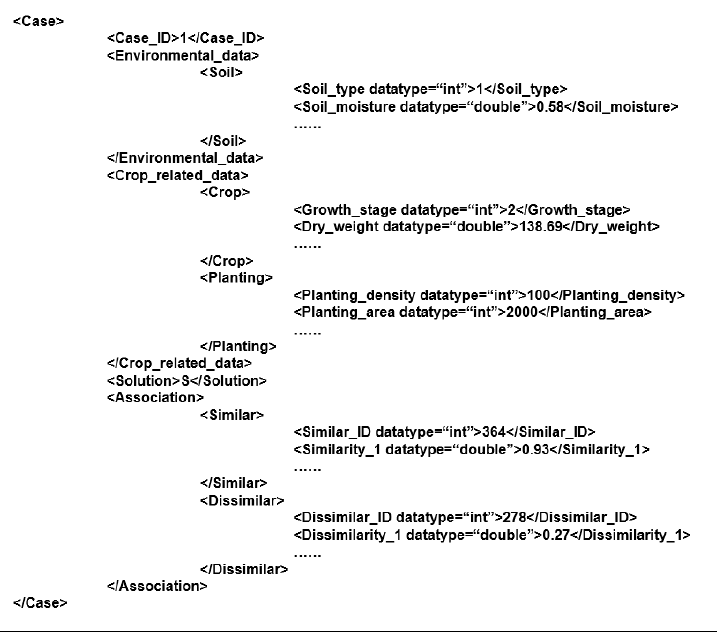
Figure 8. The association case representation in